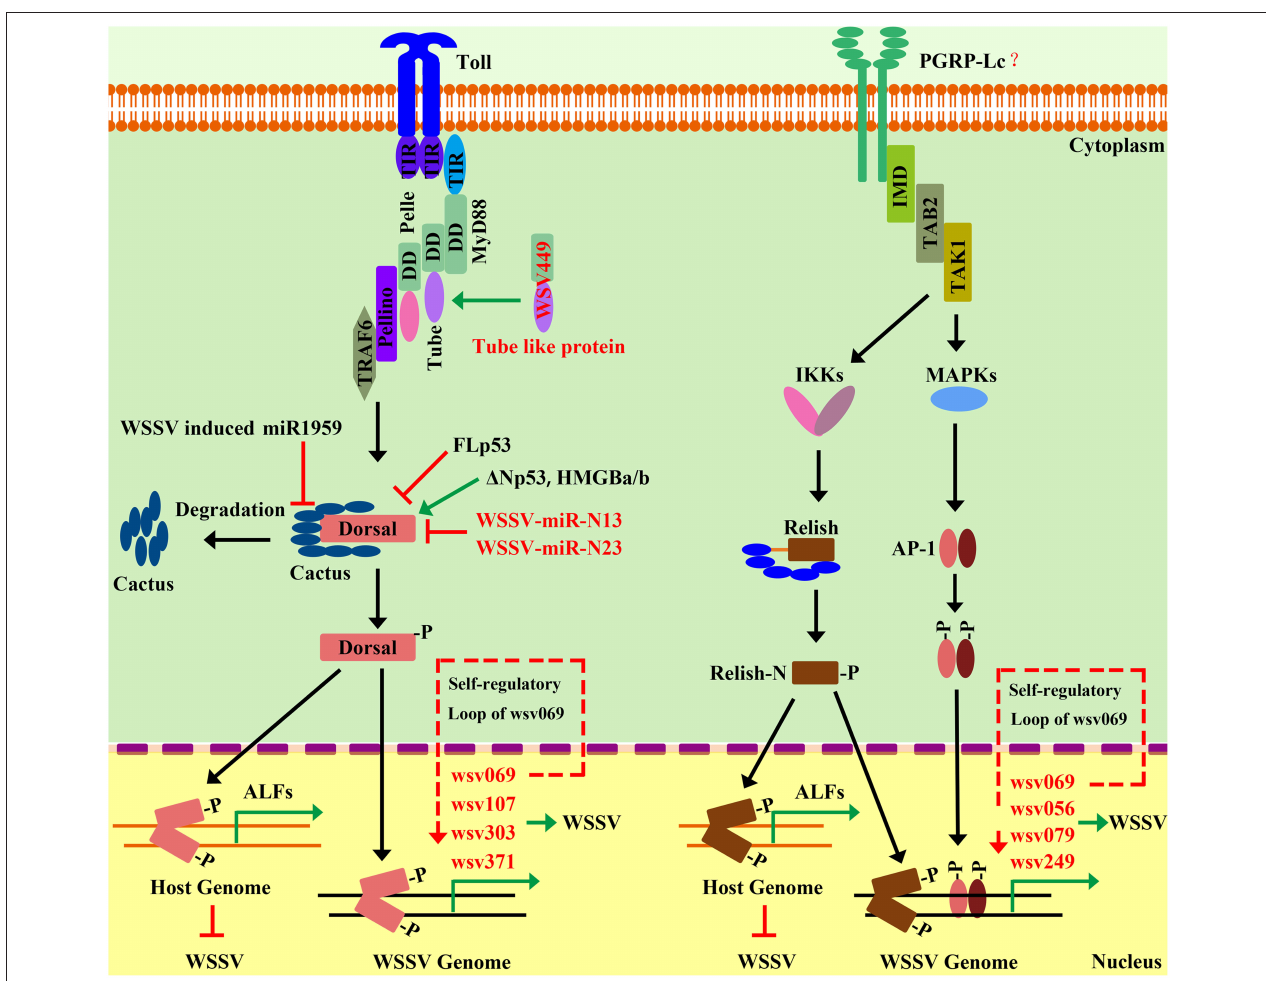
FIGURE 5 | Interplay between shrimp NF- κ B pathways and WSSV. The activation of the NF- κ B pathway can be hijacked by WSSV to favor its gene expression and genome replication. WSSV infection activates the host Toll pathway, which leads to the activation of Dorsal that translocates into the nucleus to induce viral-gene expression and promote viral-genome replication. A similar situation is observed for the IMD pathway. The activation of wsv069 mediated by the NF- κ B pathways can in turn induce its own expression, which creates a self-regulatory loop. Such a positive-feedback loop amplifies the signaling extent to further activate other viral genes. Until now, after WSSV infection, the NF- κ B pathways have been shown to be subject to numerous regulatory controls by both host factors—such as p53, miR1959, and HMGB—and viral factor, such as WSSV449, WSSV-miR-N13, and WSSV-miR-N23. However, the activation of the shrimp canonical NF- κ B pathway can also lead to AMP expression, such as ALFs, which have strong antiviral activity against WSSV. Therefore, WSSV could have evolved some currently unknown strategies to attenuate the antiviral role of the host NF- κ B pathway to instead engage its activation to favor viral